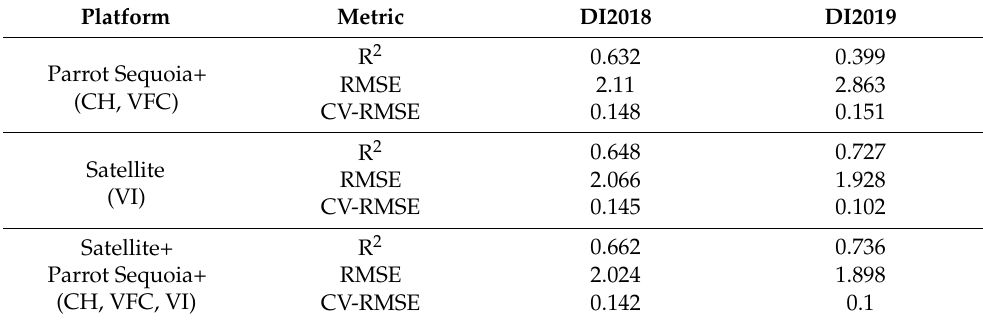
Table 5. Results for DI2018 and DI2019 using support vector regression (SVR) estimation.